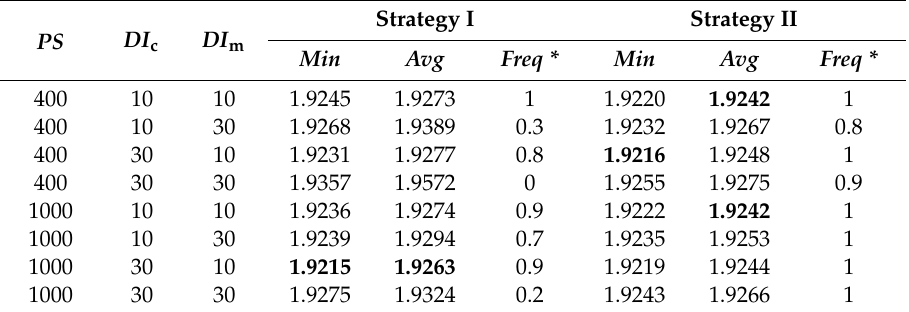
Table 2. Statistical results of solving the BIN design problem using 20 million number of function evaluations ( NFEs